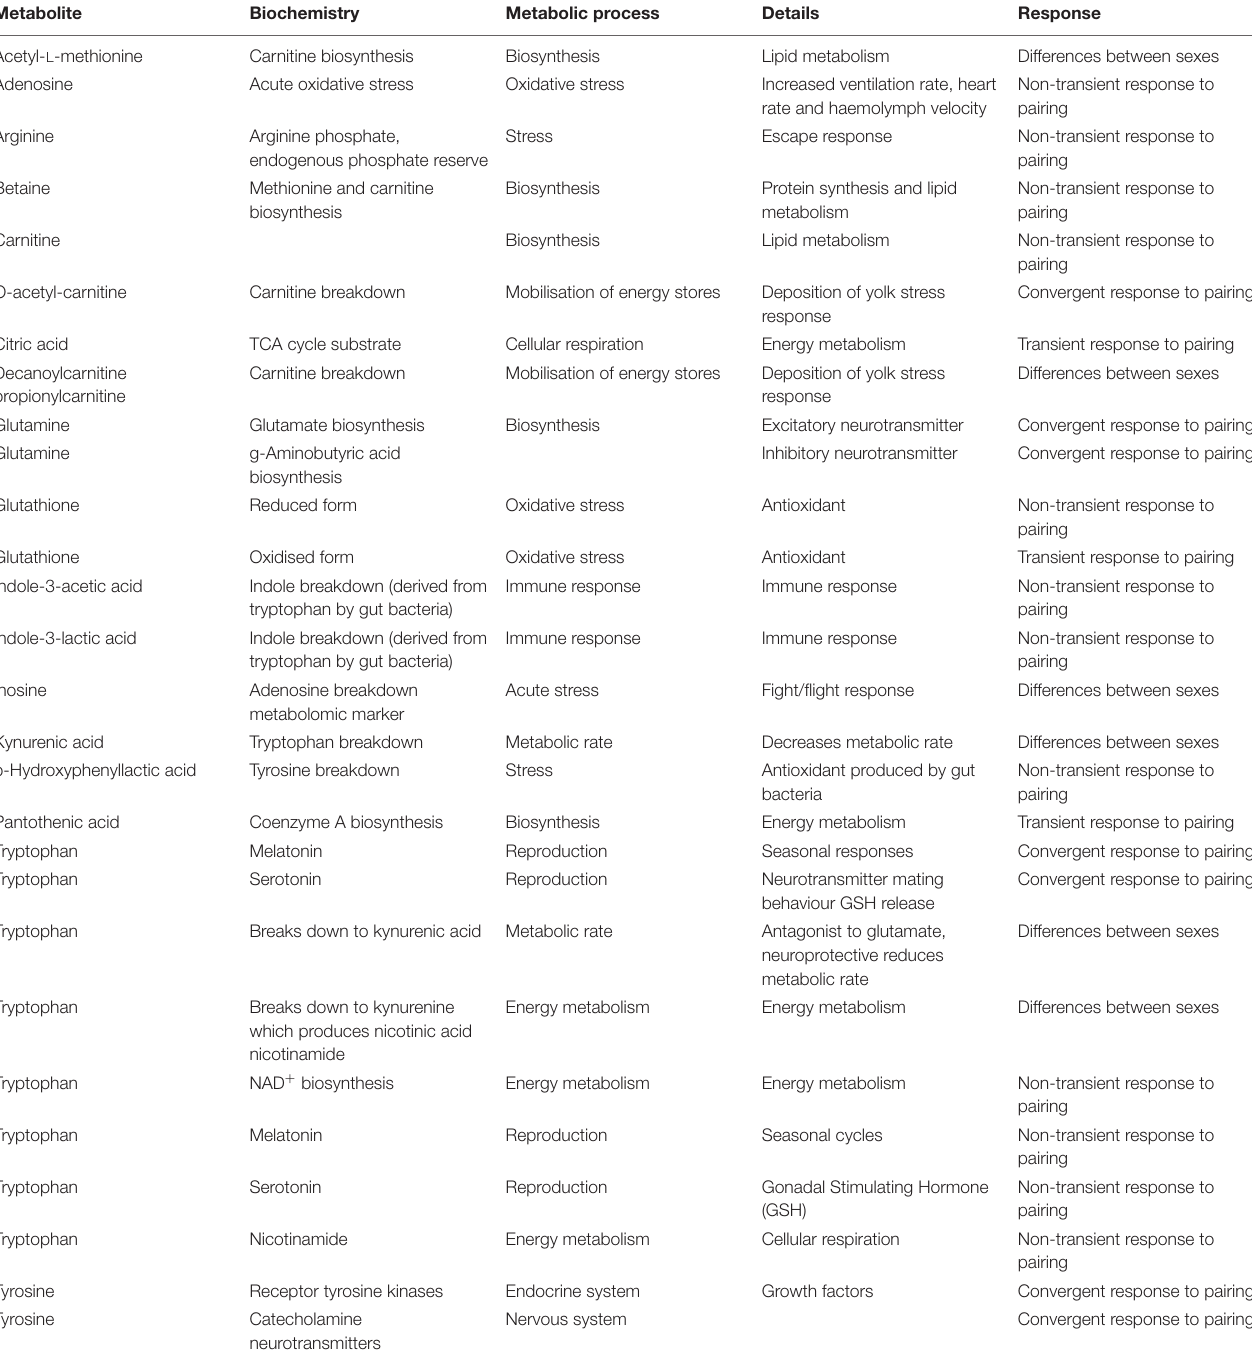
TABLE 2 | Significant metabolite markers and their putative